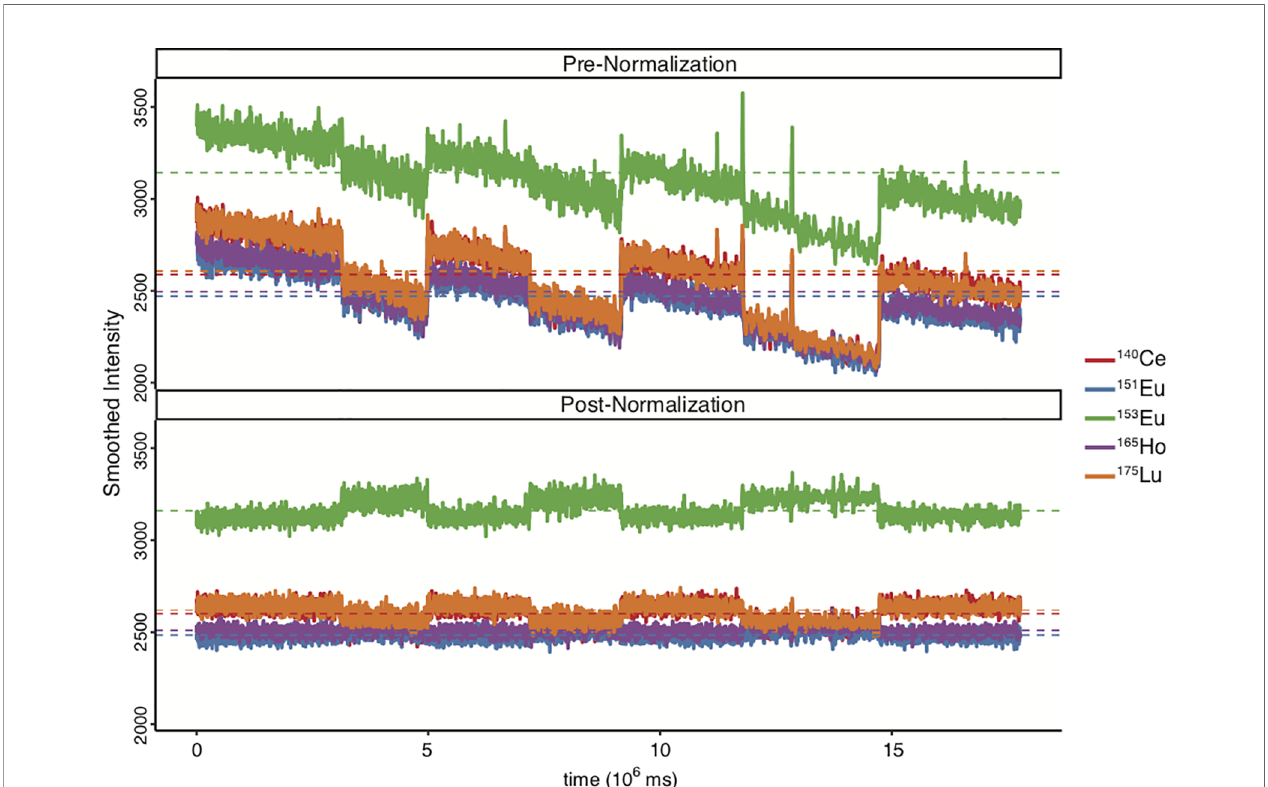
FIGURE 4 | Comparison of bead intensity over time before and after data normalization. Ce , Cesium; Eu , Europium; Ho , Holmium; Lu , Lutetium. EQ4 beads were used during sample acquisition. Figure was generated in R via the CATALYST package using their standard